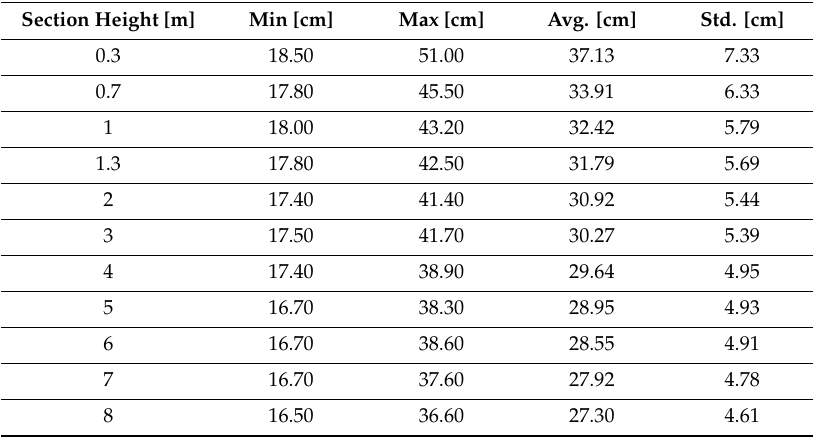
Figure 1. Location of the research plot. Table 1. Reference diameters in height sections on the research plot.